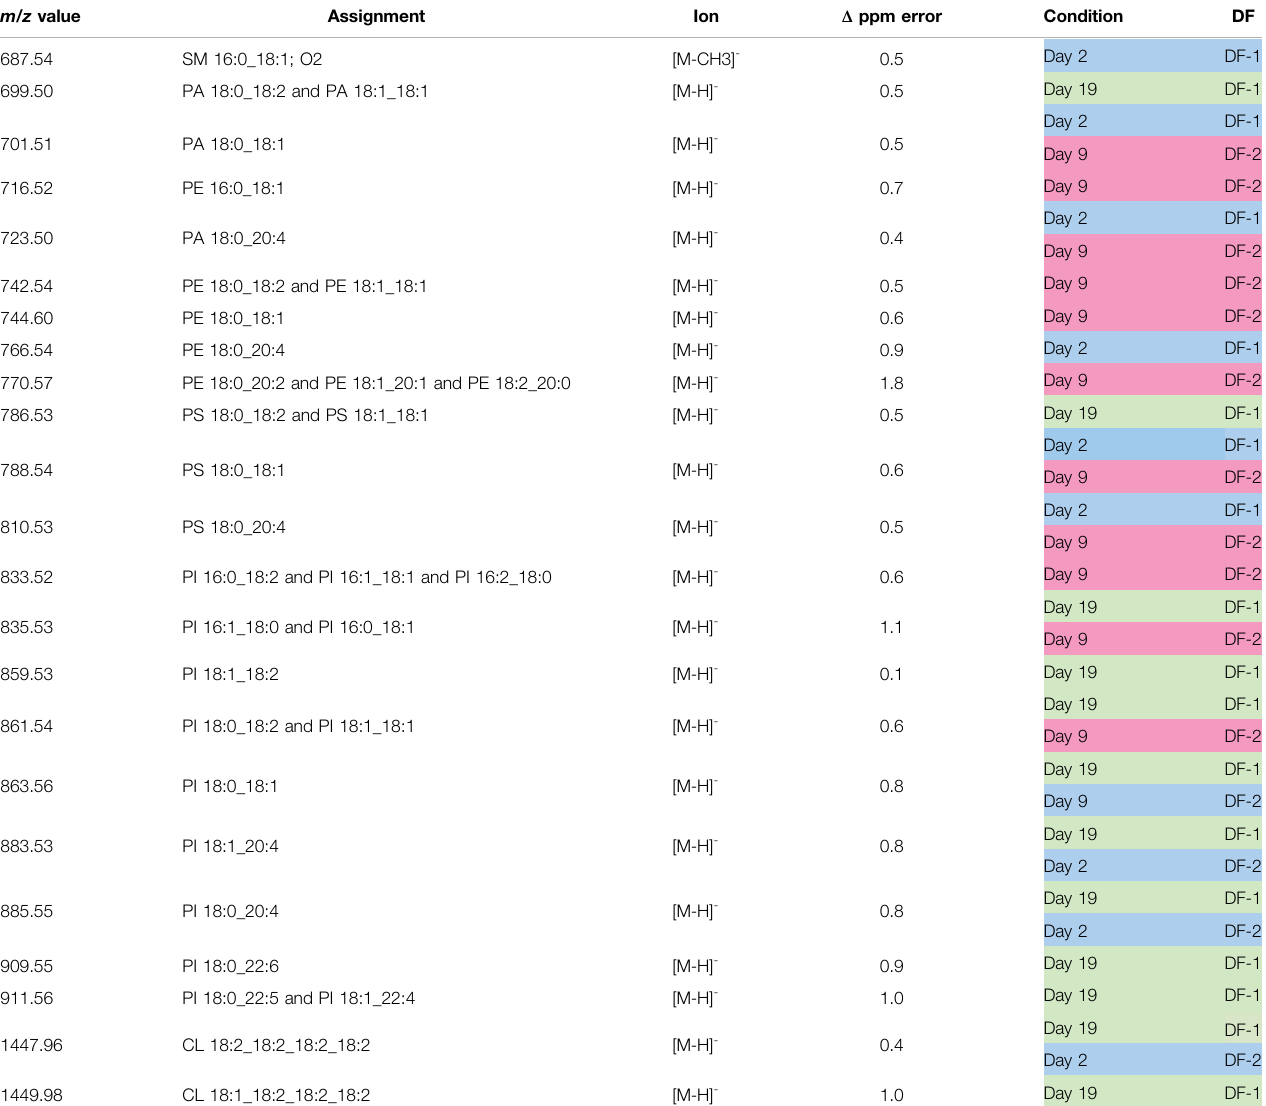
TABLE 3| Lipid assignments basedonMS/MSdataand high massresolutionexperiments innegative ionmode. Foreach assignment,the m/z valueobtained withthehigh mass resolution mass spectrometer (Orbitrap Elite), the lipid assignment, the detected ion, the ppm error, the condition to which the m/z value contributes, the DF, and the corresponding scaled loading are